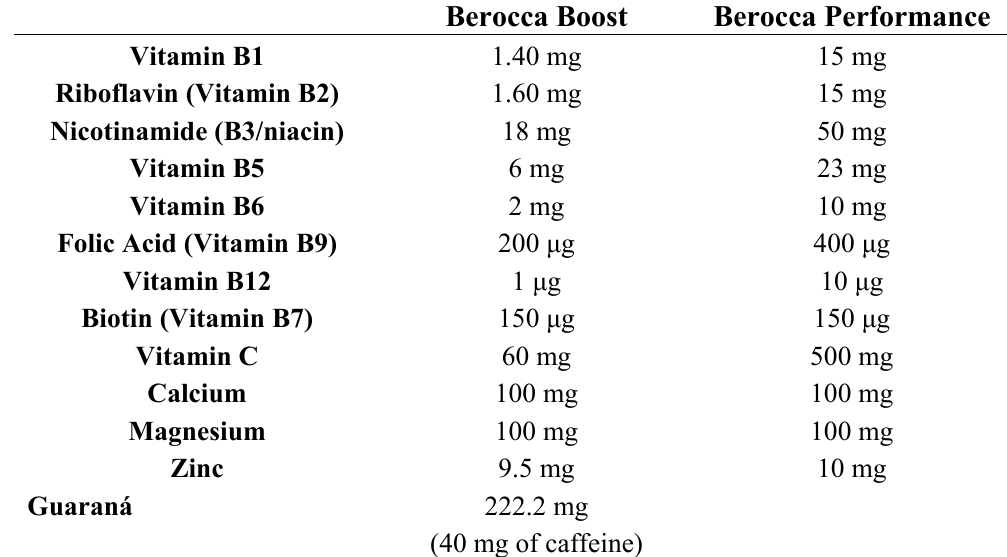
Table 1. Contents of the vitamin/mineral tablets Berocca Boost and Berocca Performance effervescent